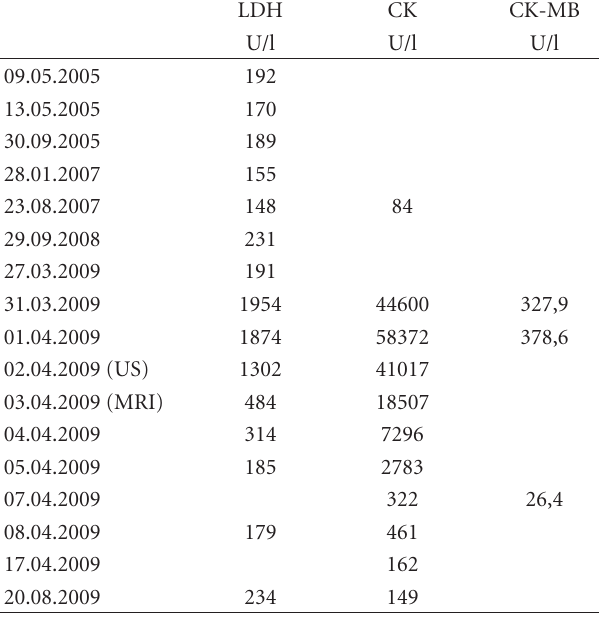
Table 1: Laboratory findings. Course of LDH (reference range < 250 U/l), CK (reference range < 190 U/l), and CK-MB serum levels. The traumatic exercise occurred on March 30th. Ultrasonography was performed on April 2nd, MRI on April